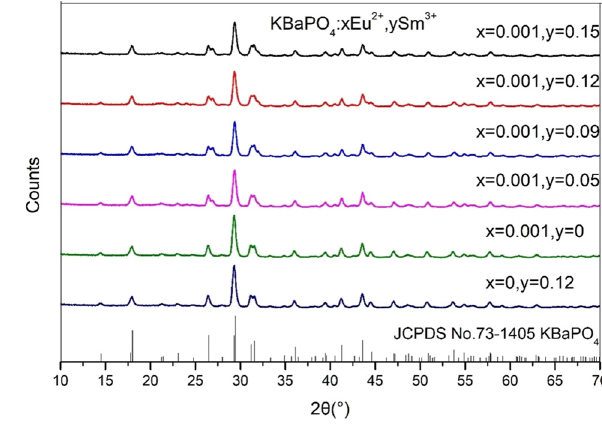
Figure 1: The fl ow diagram of the preparation steps of KBaPO 4 co - doped Eu 2 + and Sm 3 + . Figure 2: XRD patterns of KBaPO 4 : x Eu 2 + , y Sm 3 +